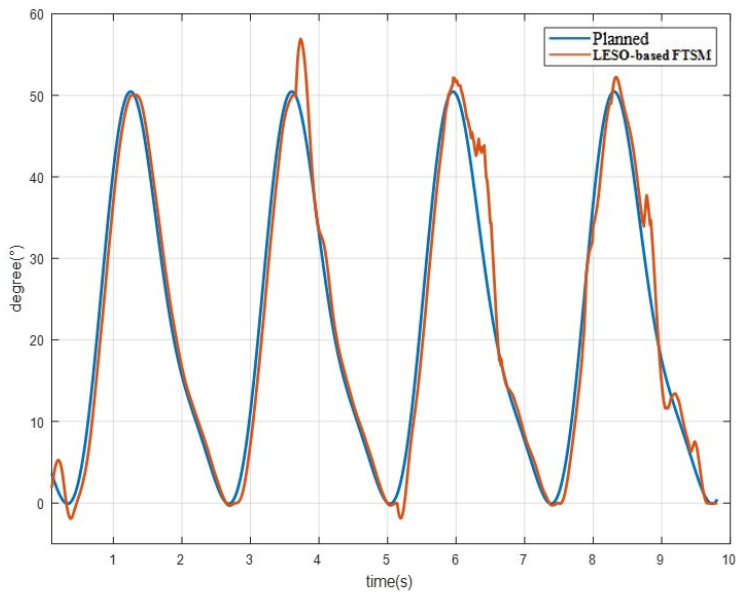
Figure 18. Trajectories of hip joint for ascending by one step per stride.